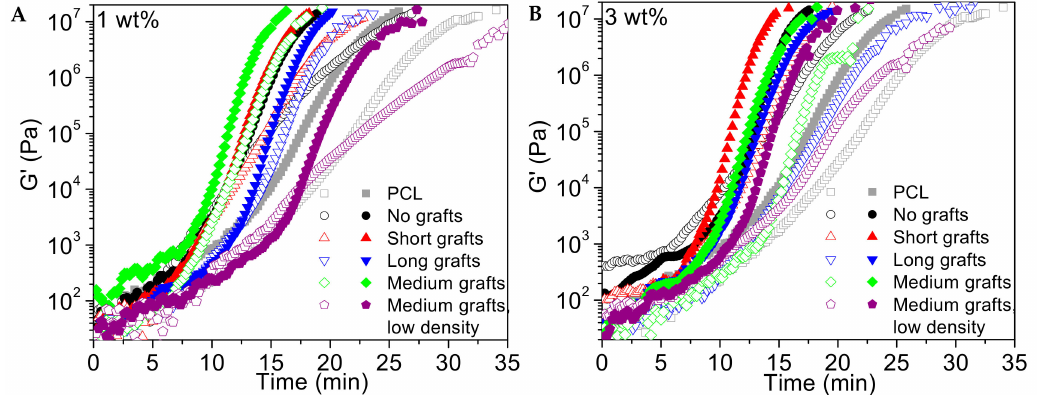
Figure 14. Storage modulus as a function of time for di ff erent PCL40 / silica composites with 1 wt% filler ( A ) and 3 wt% of filler ( B ). Open symbols corresponds to crystallization experiments without pre-shear and filled symbols to experiments where a pre-shear of 30 s − 1 was applied for 3 sec. Measurements were performed at a temperature of 47 ◦